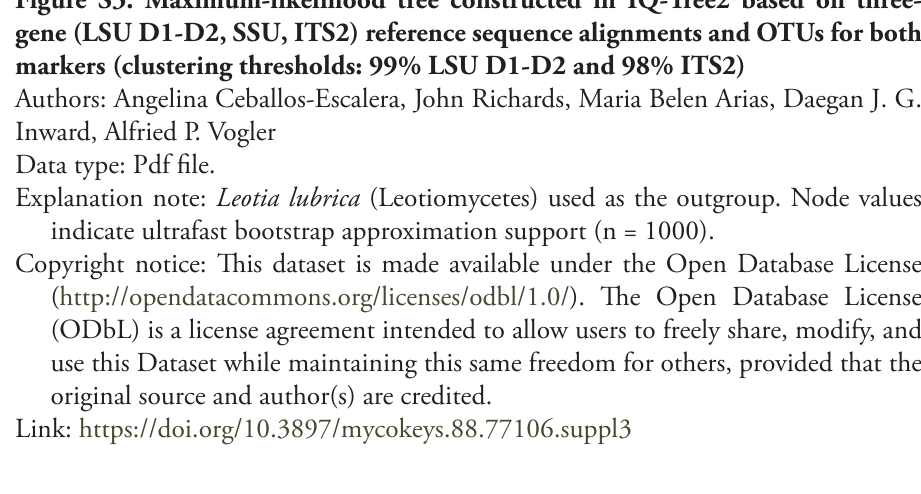
Figure S3. Maximum-likelihood tree constructed in IQ-Tree2 based on three- gene (LSU D1-D2, SSU, ITS2) reference sequence alignments and OTUs for both markers (clustering thresholds: 99% LSU D1-D2 and 98% ITS2) Authors: Angelina Ceballos-Escalera, John Richards, Maria Belen Arias, Daegan J. G. Inward, Alfried P. Vogler